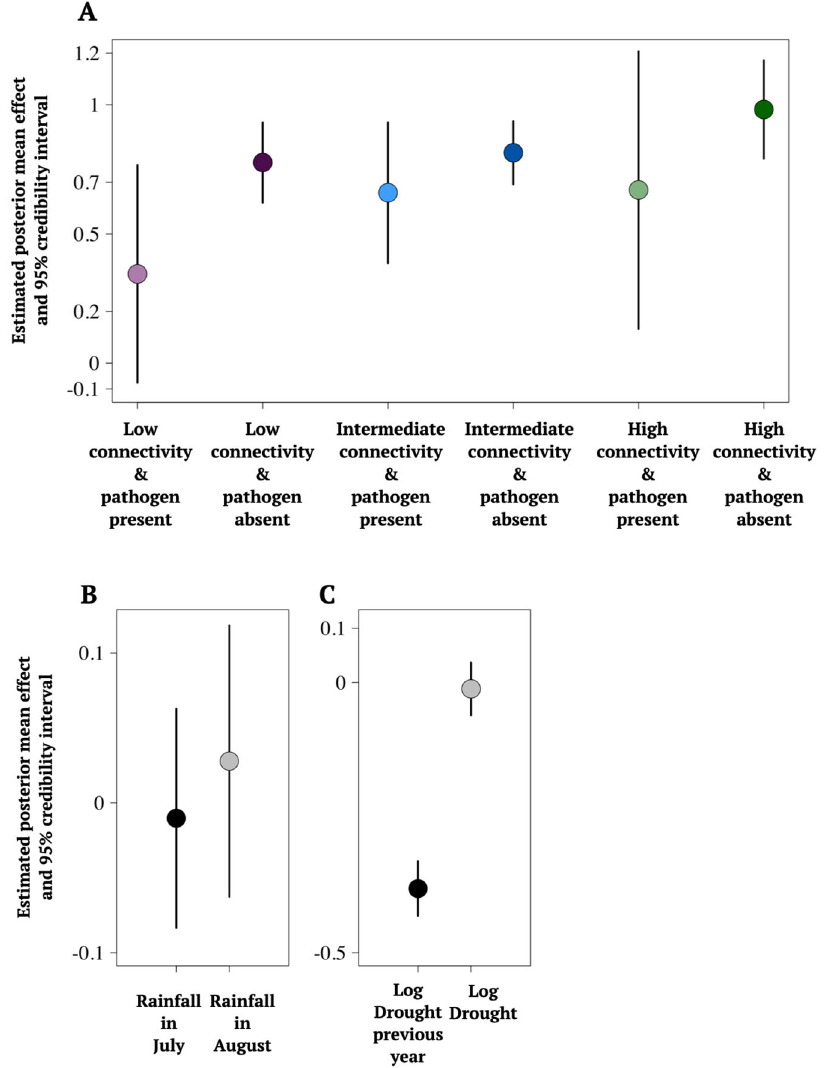
Fig.1|Modelestimatedeffectson Plantagolanceolata populationsizechanges in the Åland islands in 2001 – 2008, based on N =24042 fi eld observations. The estimatedmedianeffectsforhostpopulationgrowthwith95%credibilityintervals, shown with lines, of the fi xed effects of the Bayesian INLA model: A The effect of pathogen presence and absence in the host populations in the three connectivity categories, B the effect of rainfall in July and August; and C the effect of detected